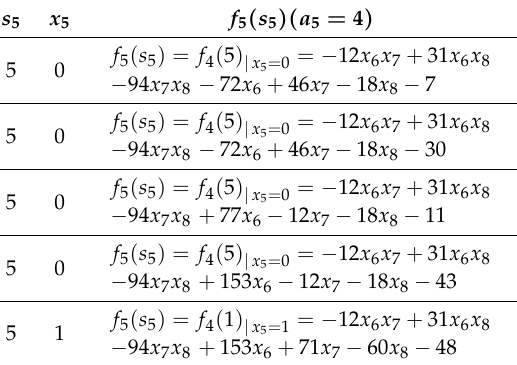
Table 5. Functions f 5 ( s 5 ) .